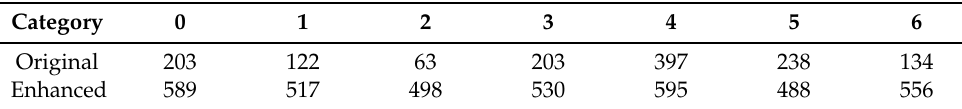
Table 1. Number of defective